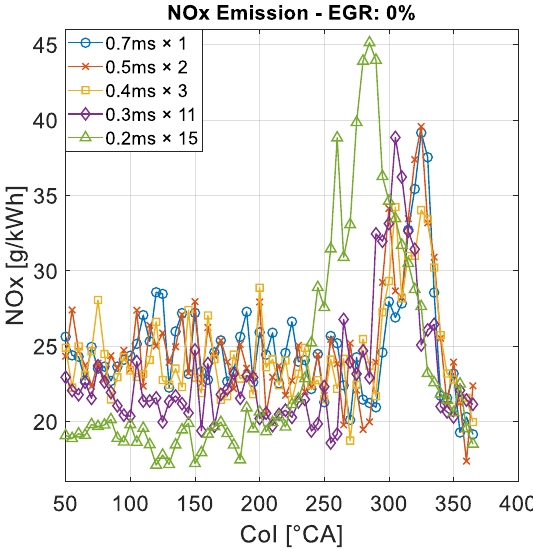
Figure 9. The NO x emission of the investigated structures with the same dose in the function of CoI without EGR.